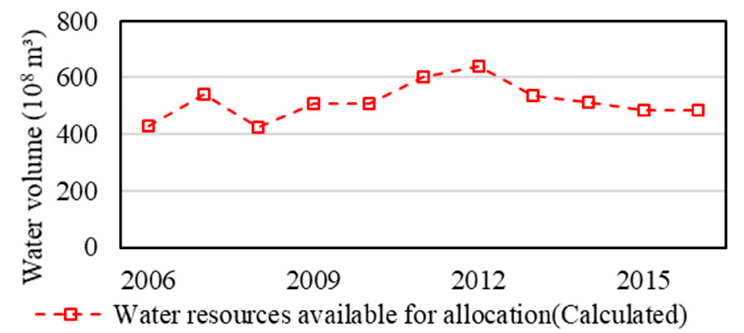
Figure 12. Available water allocation resources.